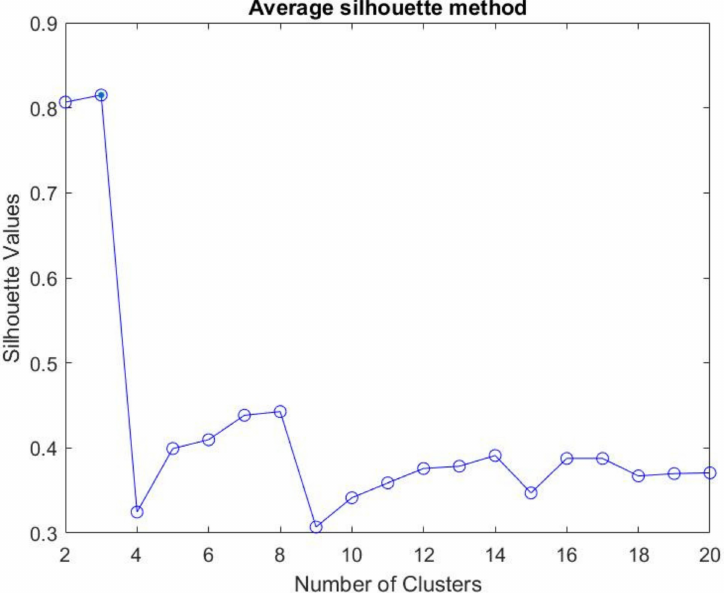
Figure 6. Identification of the ideal number of clusters for the sample under study through silhouette